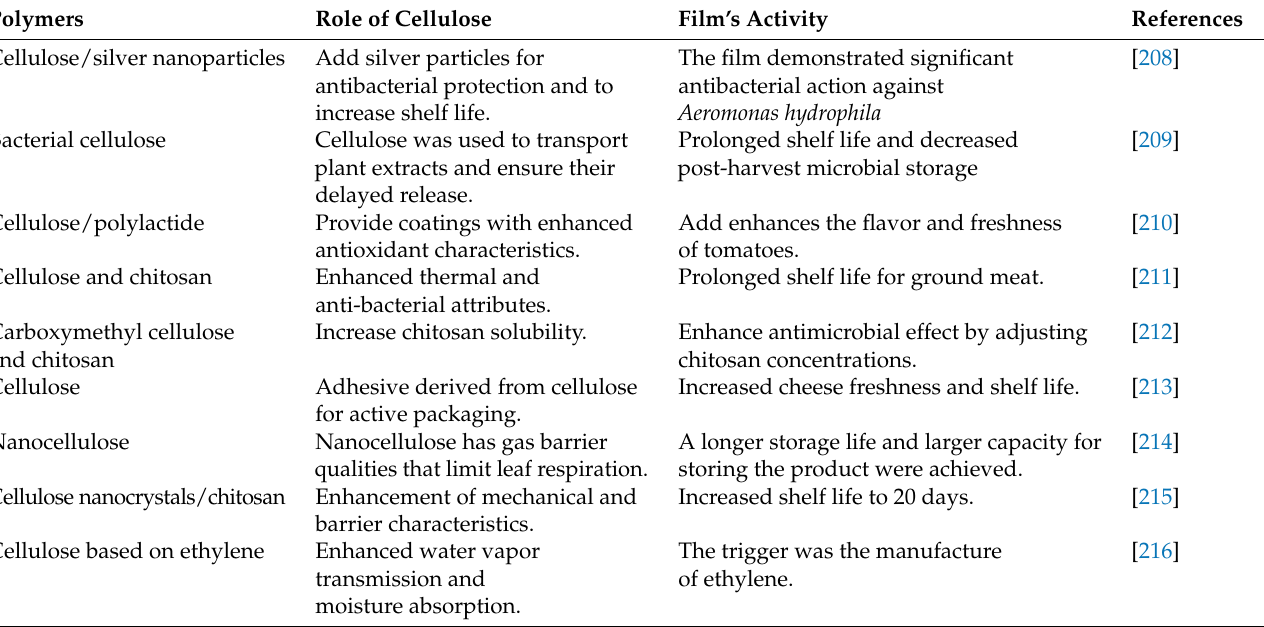
Table 2. Cellulose and its derivatives used with the other polymers to preserve